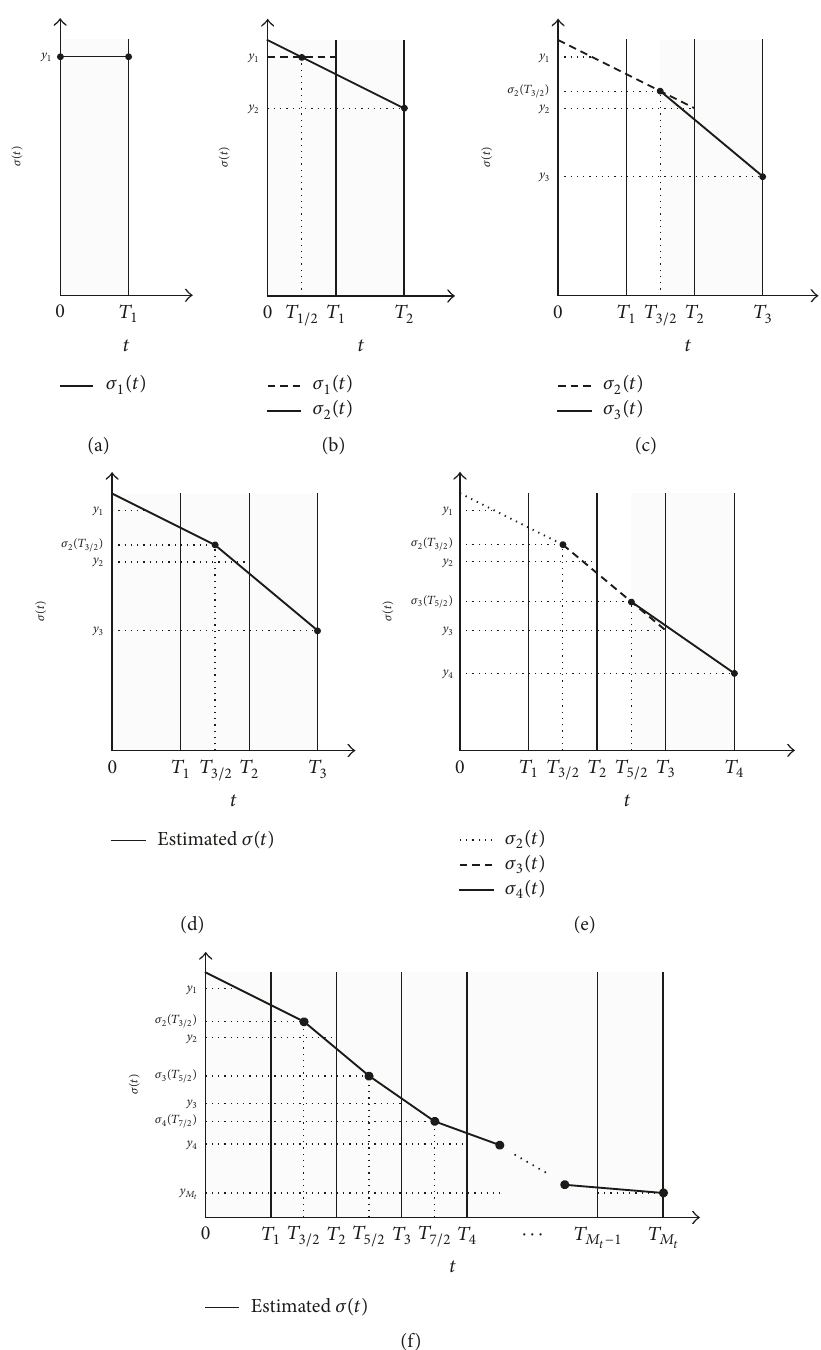
Figure 2: Schematic of procedure for time-dependent volatility